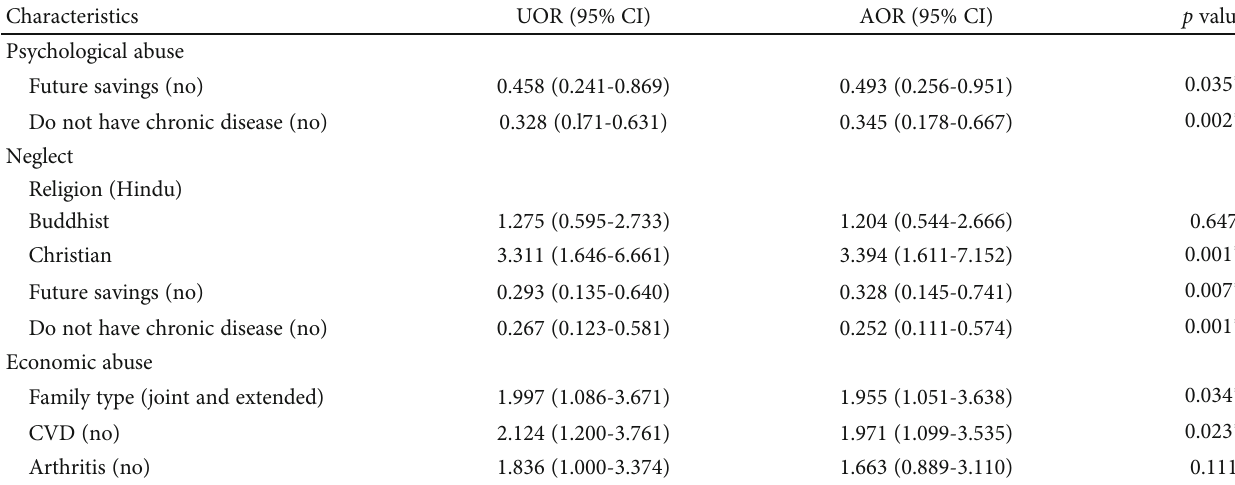
Table 2: Binary regression analysis of factors associated with types of abuse.